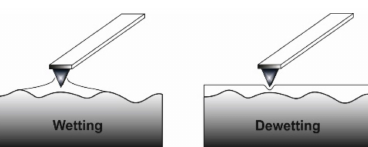
Figure 22. Schematic representation of wetting and dewetting of the AFM probe by the water layer. There were researchers such as Bhushan and Kulkarni Kulkarni [113] and Tambe and Bhusan [114] who investigated the changes that occur in the frictional behavior when the scale is modified. Their results indicate a decrease in the friction coefficient with respect to the scale decrease. This phenomenon can be generated by the modification of the contact condition between the analyzed system components that lead to an alteration of the friction